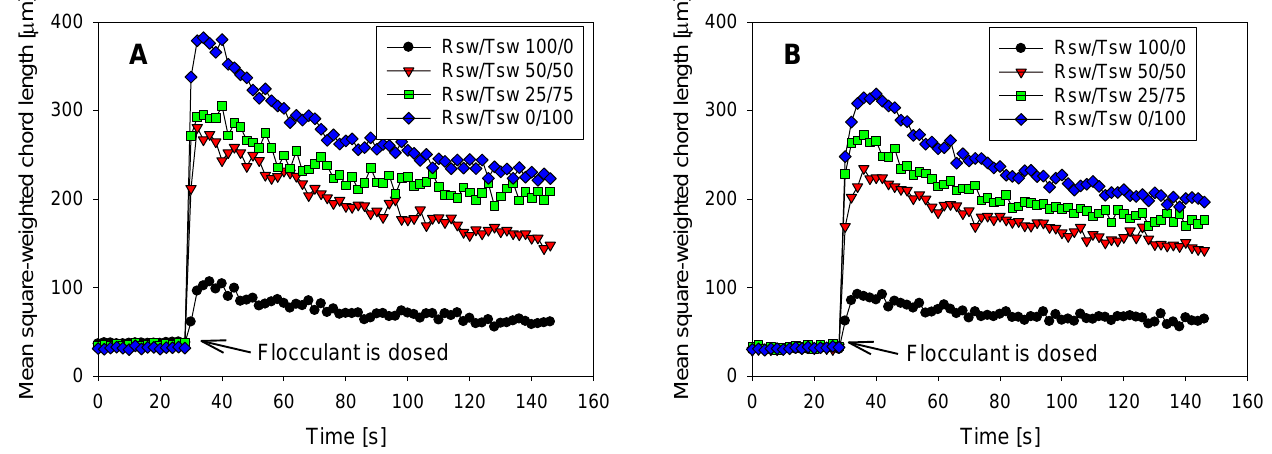
Figure 7. Flocculation kinetics (dosage 20 g/t) as monitored by FBRM for synthetic tailings made up of different ratios of raw seawater (Rsw) and treated seawater (Tsw). ( A ): Qz/Kao 90/10; ( B ): Qz/Kao 75/25.